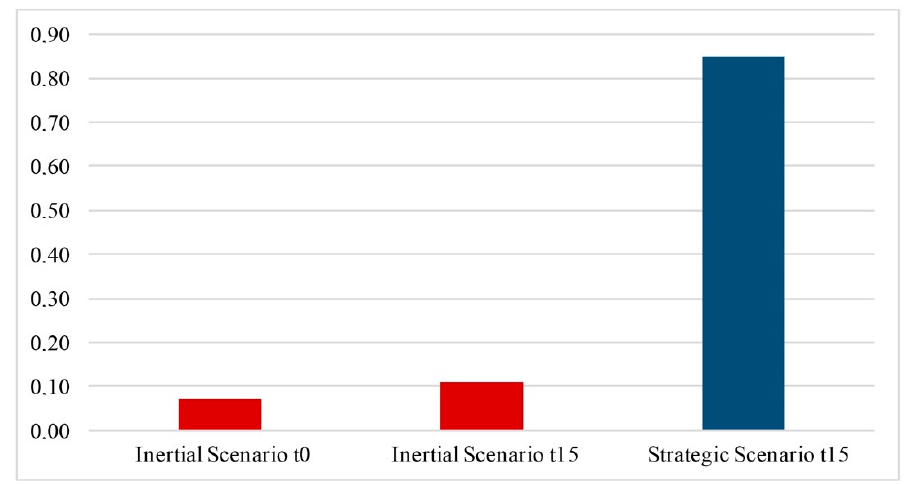
Figure 15. Urban Resilience Index .